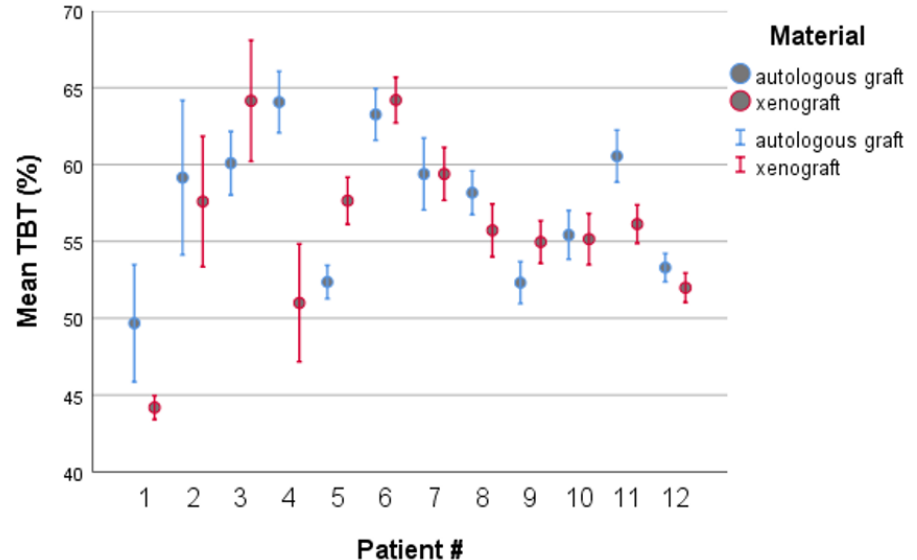
Figure 4. Clustered 95% confidence intervals for average THT by patient and by material, obtained from 10 slides in each condition.